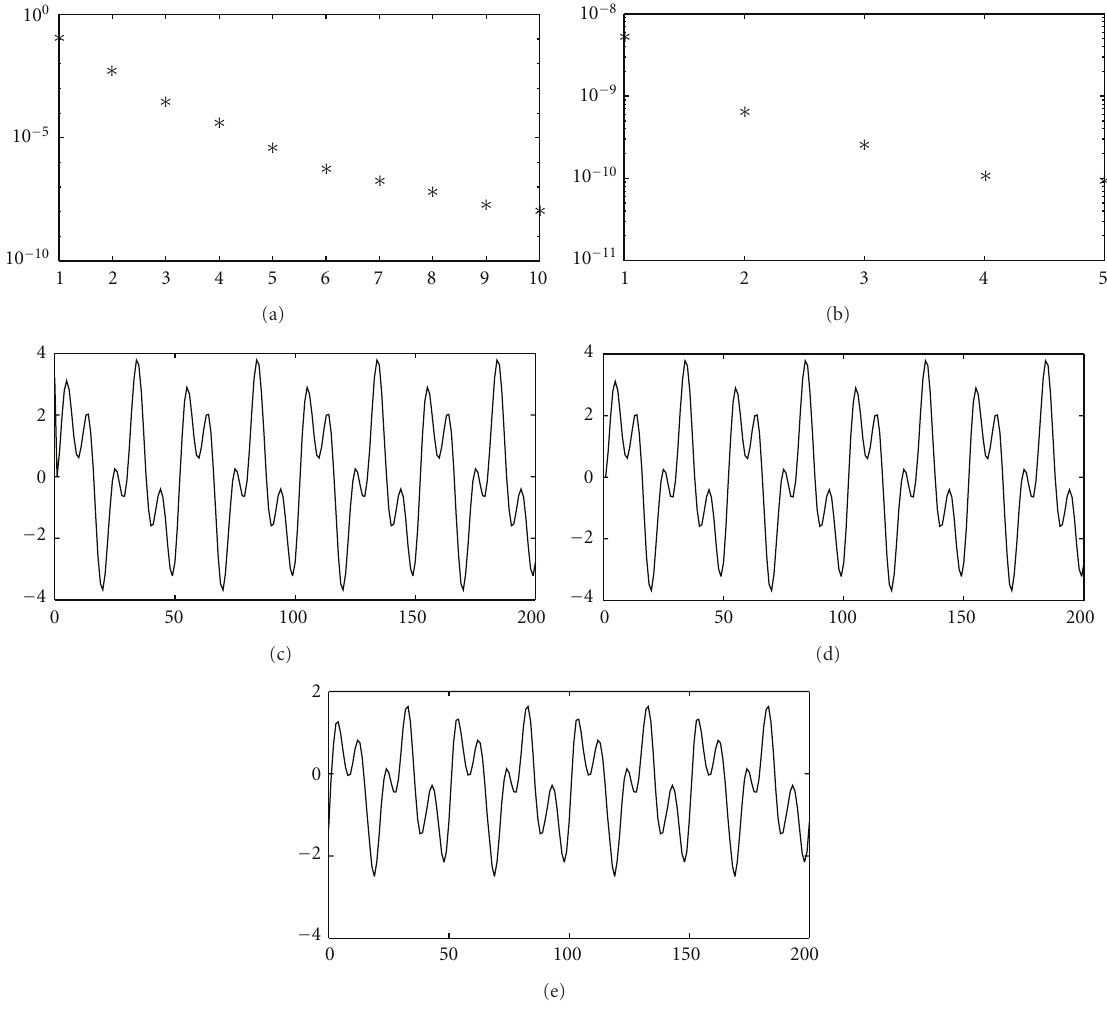
j Figure 3: (a) max t ∈{ 1, ... ,200 } | e c ( t ) | versus control iteration j . (b) max t ∈{ 0, ... ,200 } | e 10, iteration. (c) y 10 ( t ) (dotted line) and y d ( t ) (solid line) versus time t at the 10th control iteration. (d) (cid:23) y 10 ( t ) (dotted line) and y 10 ( t ) (solid line) versus time t at the 10th control iteration. (e) u 10 ( t ) at the 10th control iteration versus time t